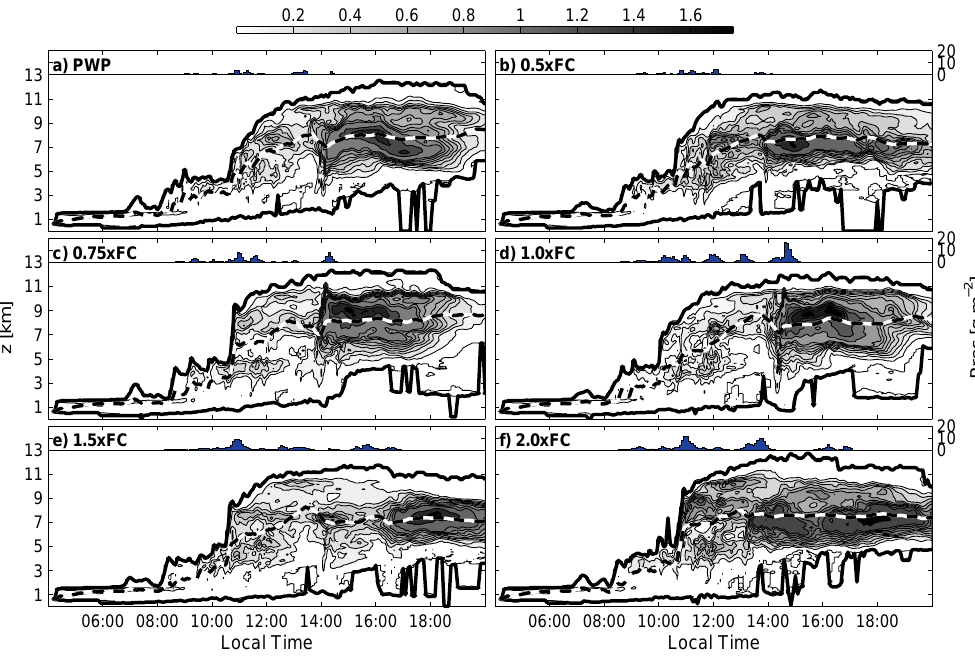
Figure 8. Modelled development of convection at Nam Co Lake for cases PWP, 0.5 × FC, 0.75 × FC, 1.0 × FC, 1.5 × FC and 2.0 × FC on 17 July 2012: contours correspond to mean cloud water equivalent concentrations in the Nam Co Lake basin [gm − 3 ]. The dashed line indicates the height of the centre of cloud mass ( Z c ) and black lines indicate cloud top and cloud bottom heights. The upper panel of each subplot indicates mean deposited precipitation within each 5min interval [gm − 2